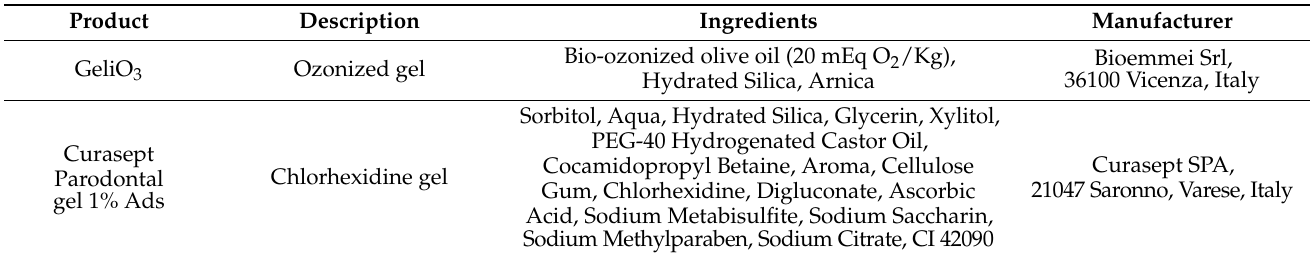
Table 1. Products tested in the